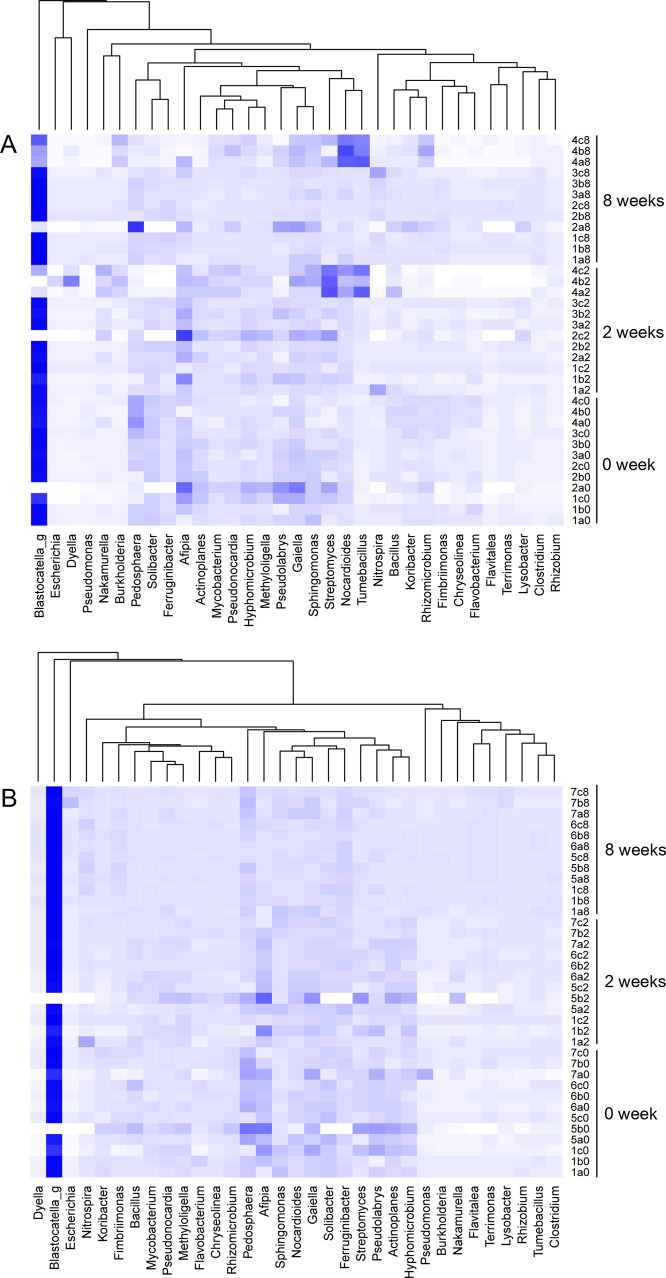
The heat map showing the relative abundances of the most abundant genera at different MWCNTs concentrations applied to soil over time (at T = 0 weeks, 2 weeks, and 8 weeks).The numbers written on Y-axis indicate the concentration of MWCNTs (1: 0 μg/g, 2: 50 μg/g, 3: 500 μg/g, 4: 5000 μg/g of fMWCNTs and 5: 50 μg/g, 6: 500 μg/g, 7: 5000 μg/g of raw MWCNTs), and the letters indicate the replicates.